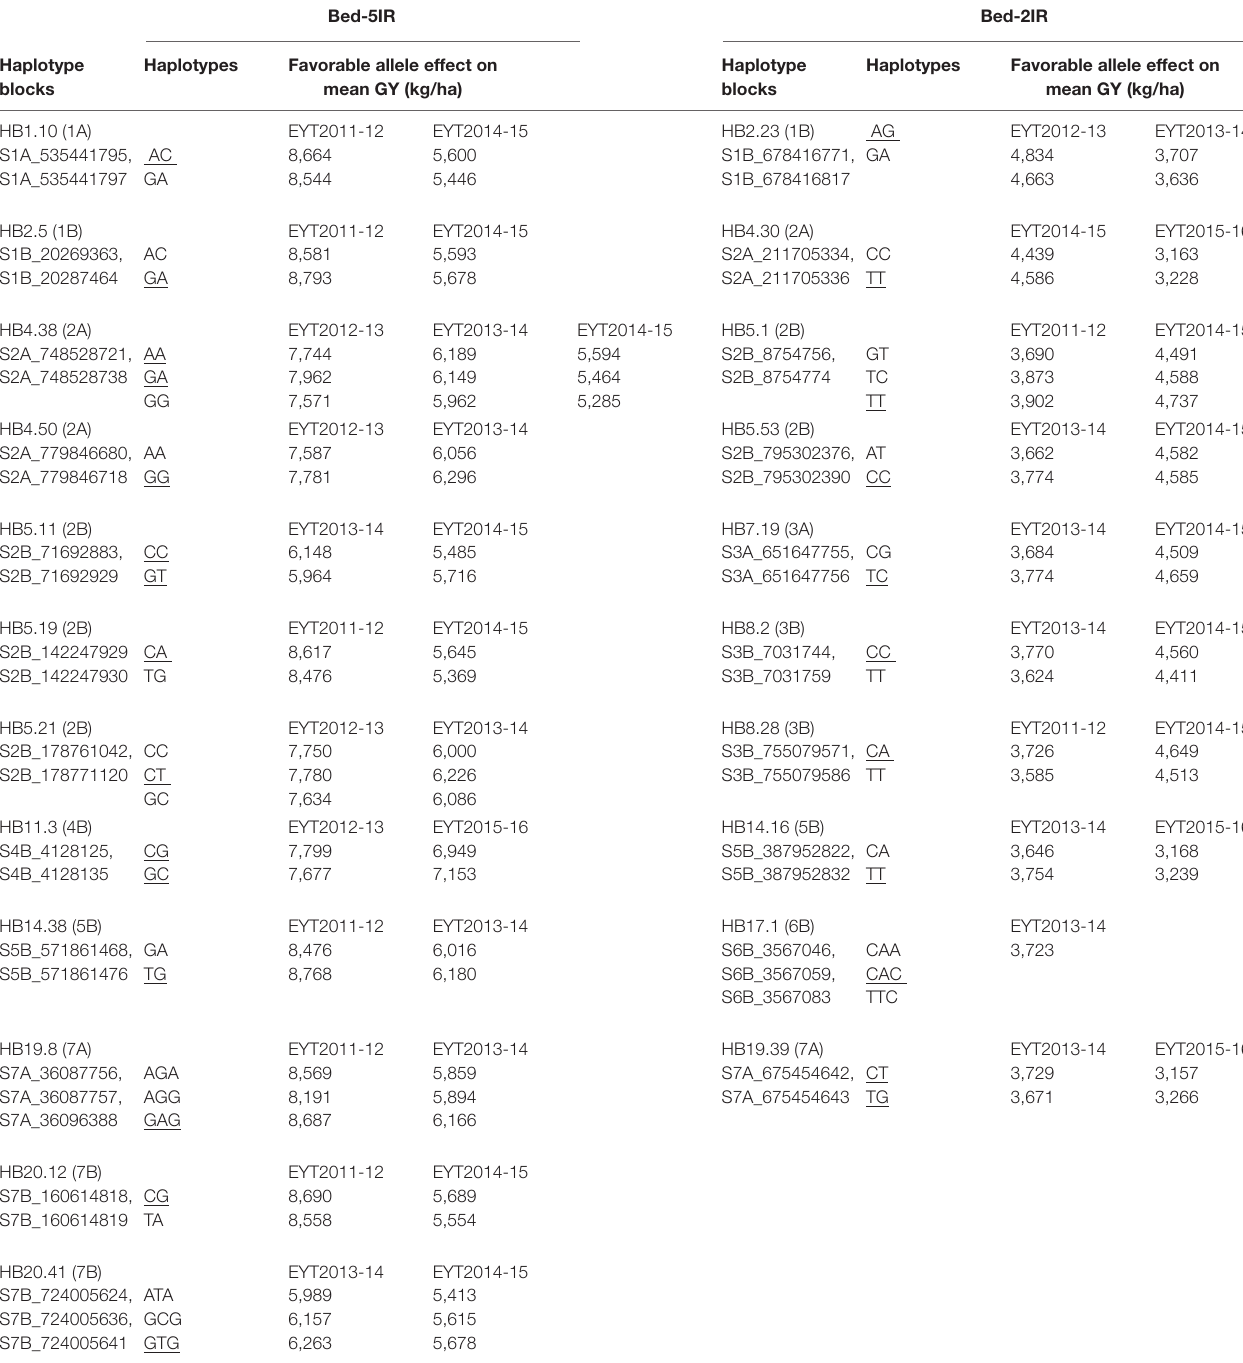
TABLE 2 | Haplotype blocks used as fixed effects in GS models for GY in B-5IR and B2-IR environments. The favorable haplotype(s) is